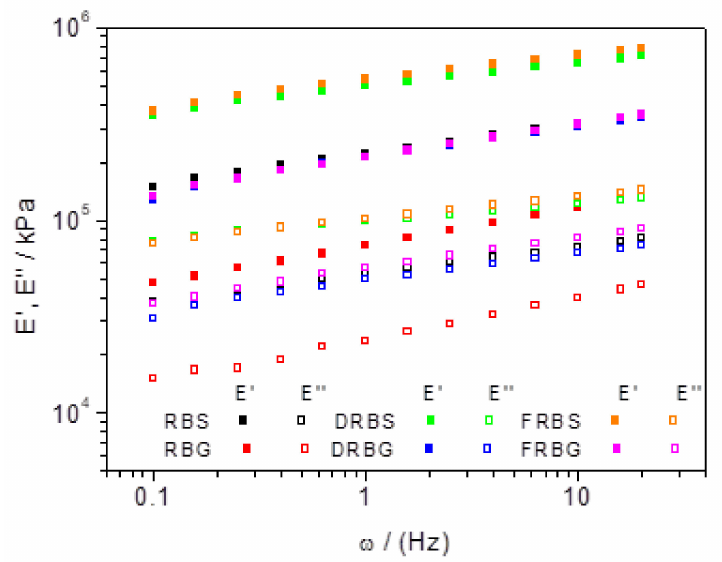
Polymers 2022 , 14 , x FOR PEER REVIEW 7 of 15 Figure 1. Frequency sweep tests performed between 0.1 and 20 Hz of the different studied systems (RBS, RBG, DRBS, DRBG, FRBS, and FRBG) carried out at room temperature.